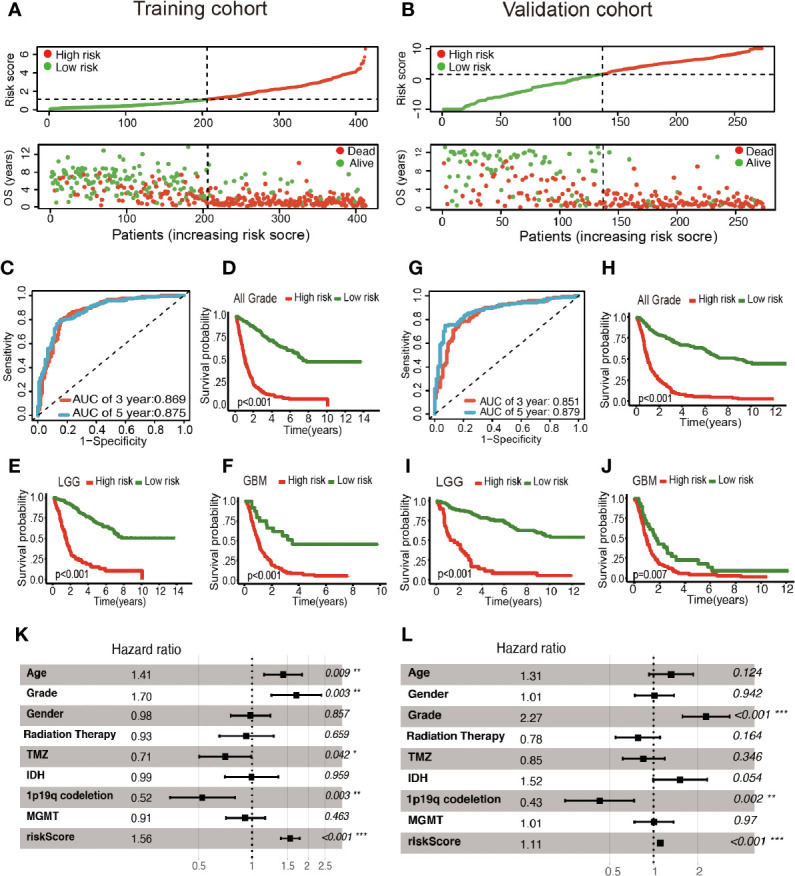
Construction of the glycolysis-related LncRNAs signature for survival prediction. (A, B) Risk score distribution, survival status for patients in low- and high-risk groups by the LncRNA signature. ROC curves of the signature for predicting 3- and 5- year survival of glioma in both training (C) and validation cohorts (G). Kaplan–Meier curve based on the identified survival-related glycolysis LncRNAs in the training (D–F) and validation (H–J) cohorts. (K, L) Multivariable comparison of clinical features and the risk score. *P < 0.05, **P < 0.01, and ***P < 0.001.